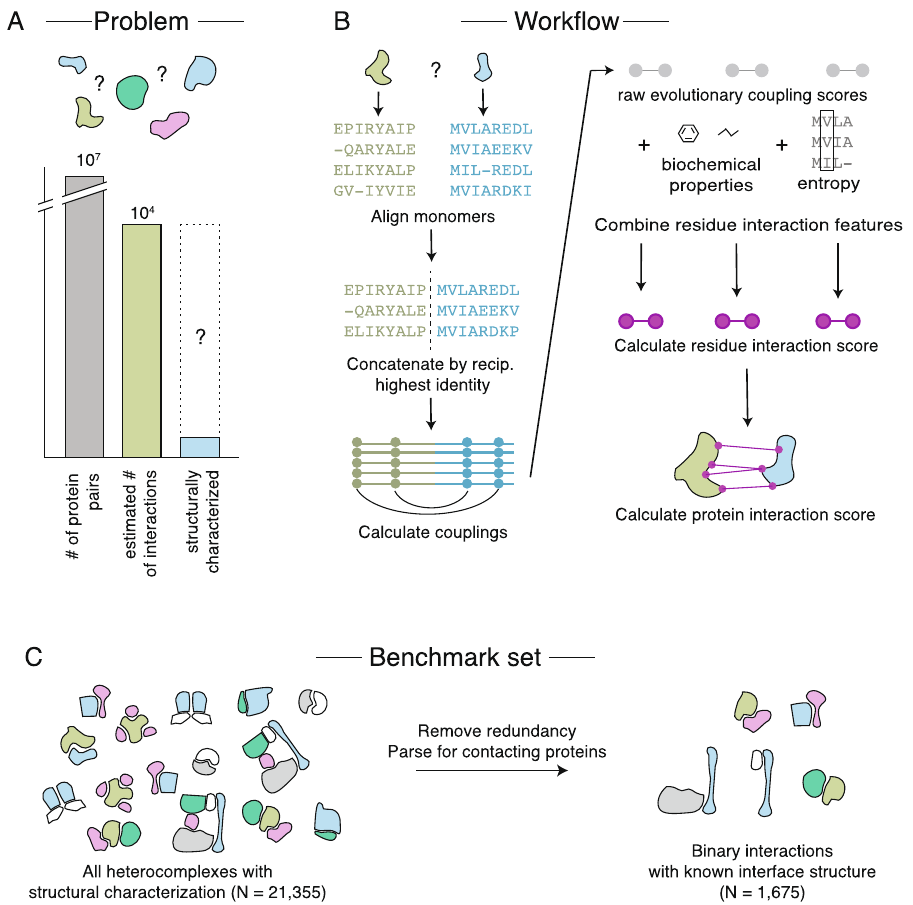
Fig. 1 Scaling EVcouplings methods to full bacterial genomes. A The search problem for binary protein-protein interactions in Escherichia coli involves fi nding all of the estimated 10 4 true interactions out of 10 7 possible pairs. Only approximately 9% of these true direct interactions have a crystal structure solved in E. coli or a homologous structure in another organism. B Evolutionary couplings learned directly from protein sequences can resolve interfaces. Sequence alignments of both monomeric proteins are created and concatenated by the reciprocal highest identity procedure before inference of evolutionary couplings. Raw evolutionary coupling scores can be combined with features of their distribution, biochemical properties, and sequence entropy to improve inference. C A benchmark dataset of all non-redundant protein interactions with known interface